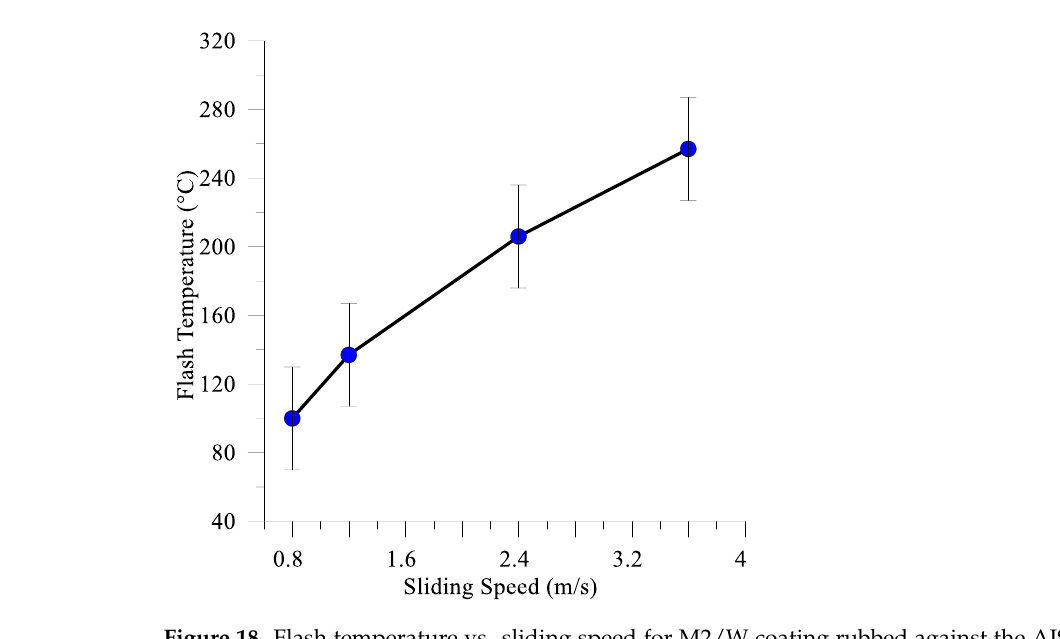
Figure 18. Flash temperature vs. sliding speed for M2/W coating rubbed against the AISI 52,100 counterbody.